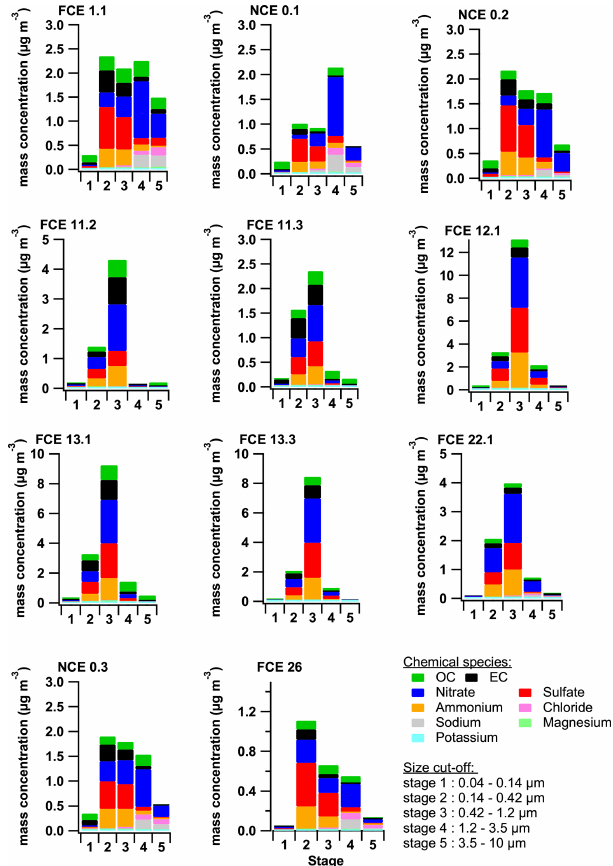
Figure 2. Size distribution of OC, EC, and major water-soluble ions from Berner impactor measurements for the different full cloud events (FCE) and non-cloud events